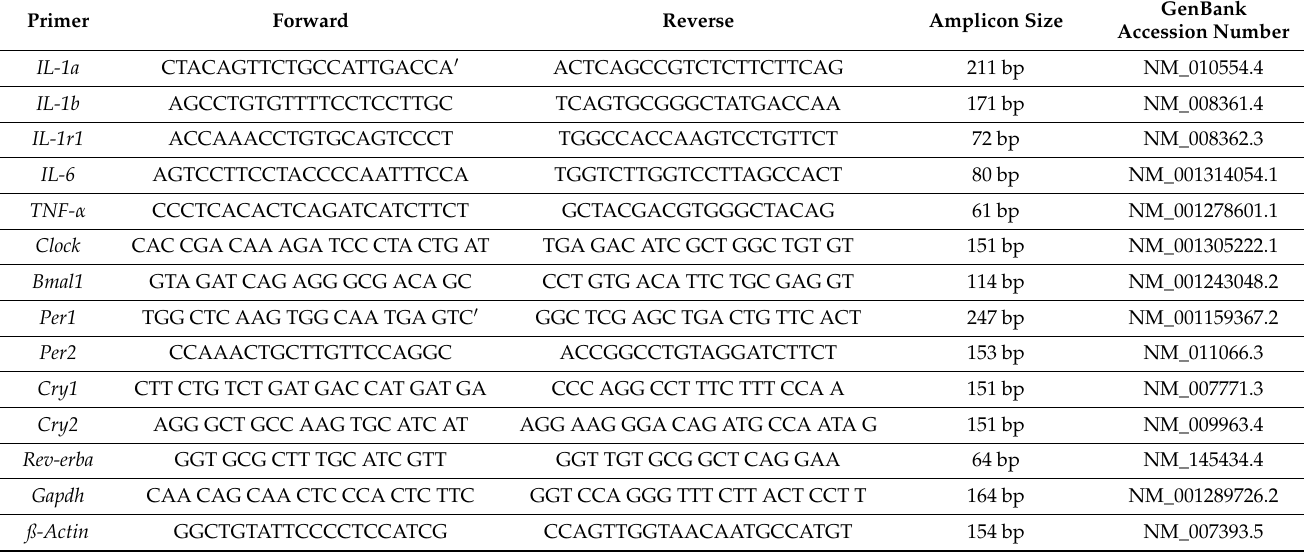
Table 1. List of primers used for real time qPCR.